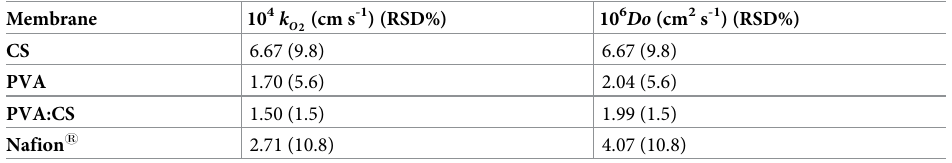
and Do were calculated from Eqs 4 and 5, O 2